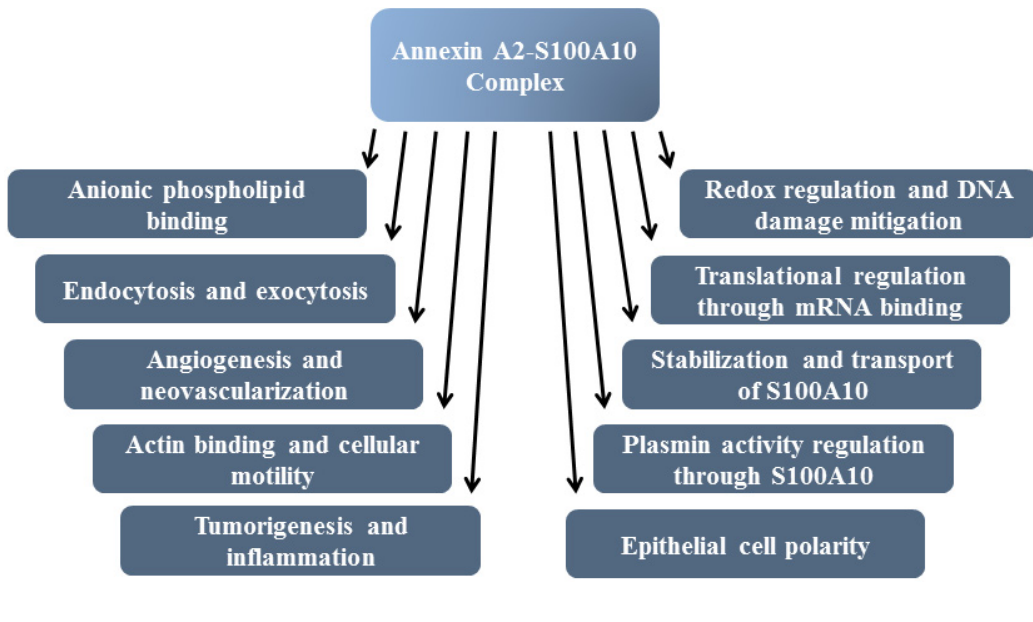
Figure 5. Functions of annexin A2-S100A10 complex. The schematic diagram summarizes the functions of annexin A2 discussed in the